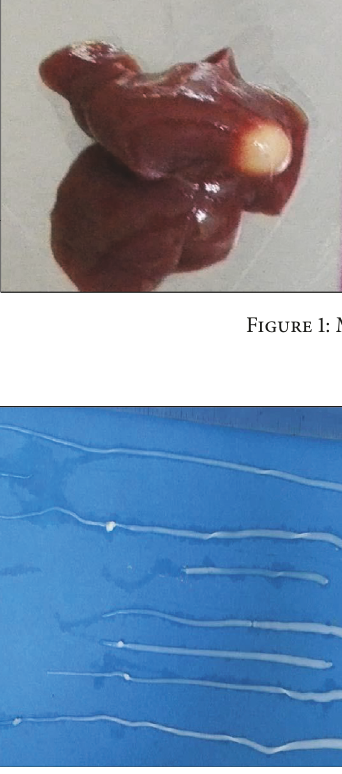
Figure 2: The Cysticercus fasciolaris taken out from the cysts. Somvanshi [1] we also found lymphocytic cuffing around the cysts (Figure 3).